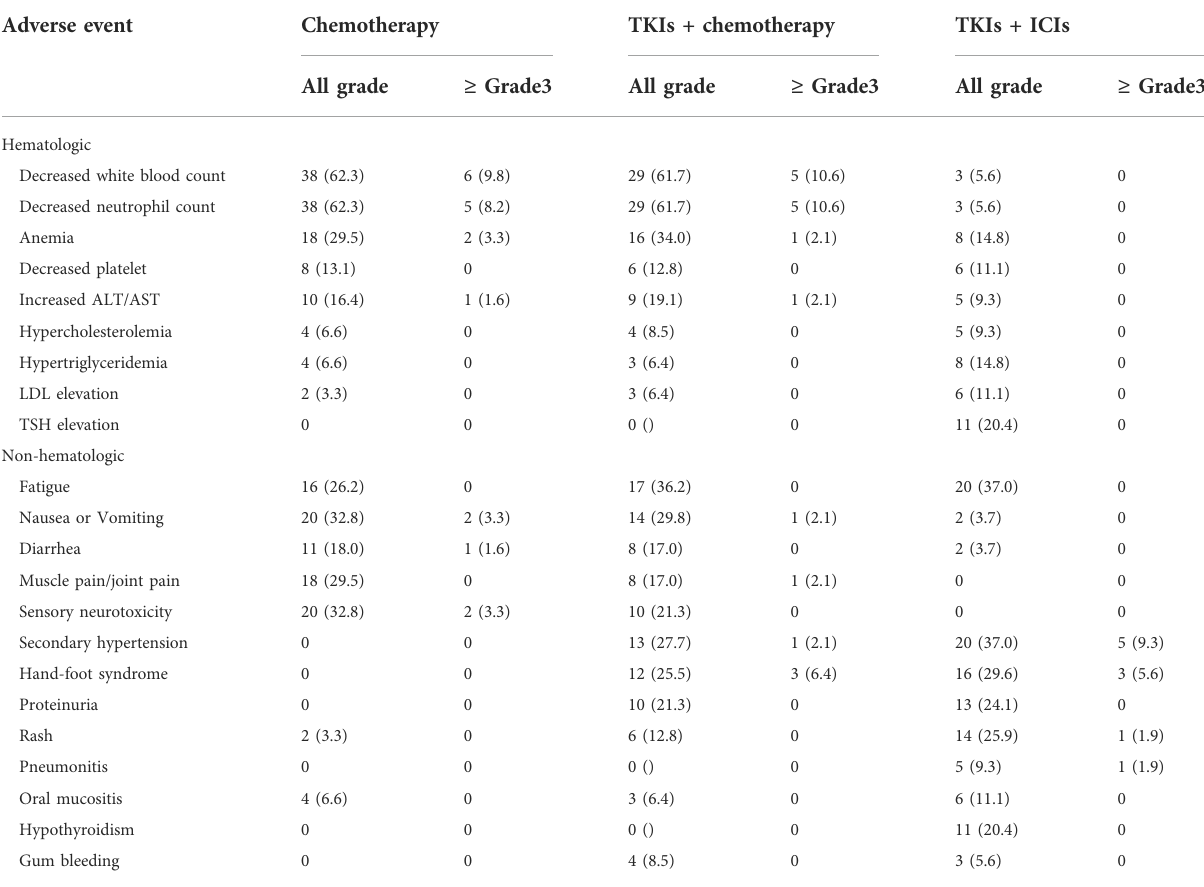
TABLE 4 Treatment-related AEs (TRAEs).